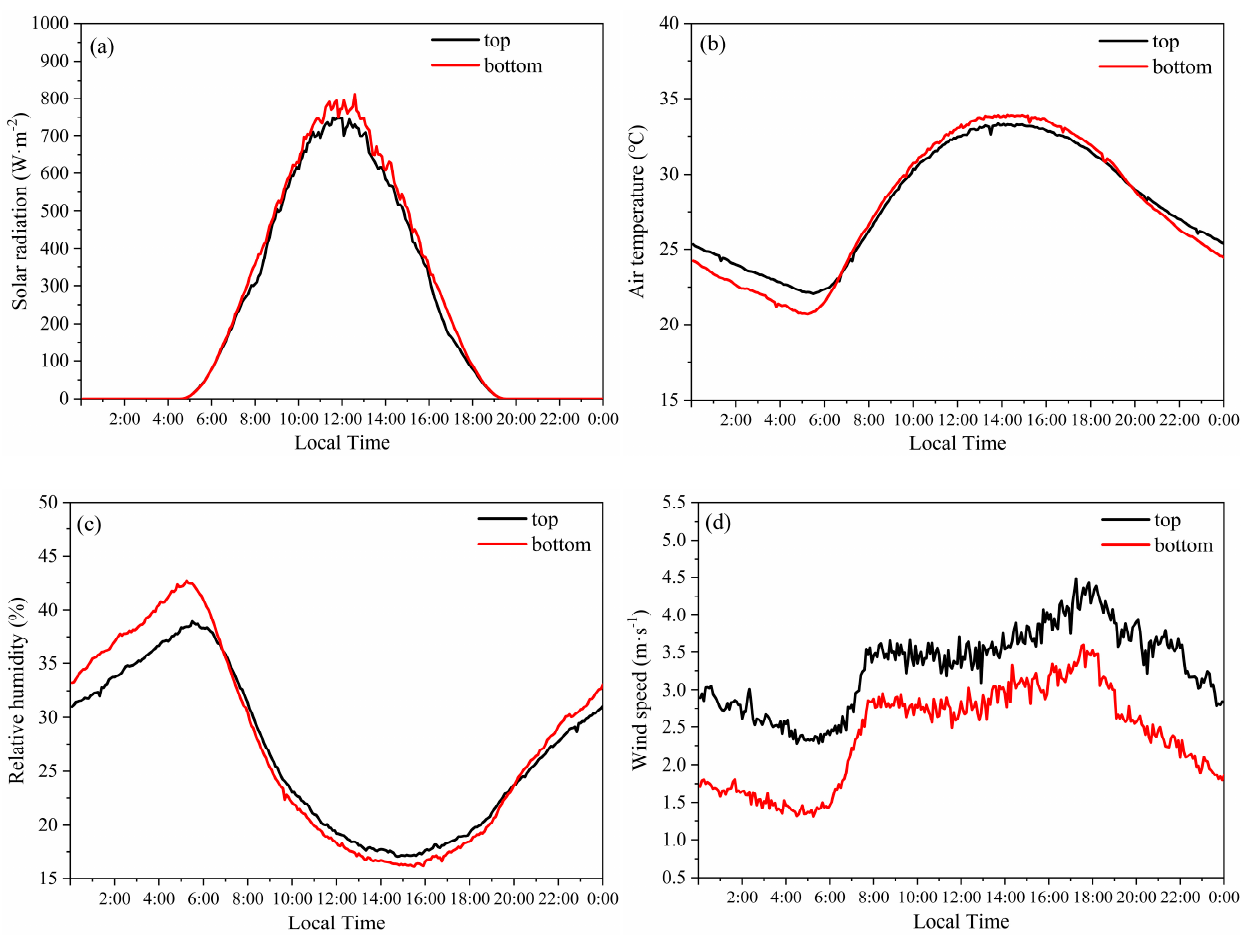
Figure 7. Mean diurnal variations in SR ( a ), T ( b ), RH ( c ), and WS ( d ) during observation in the